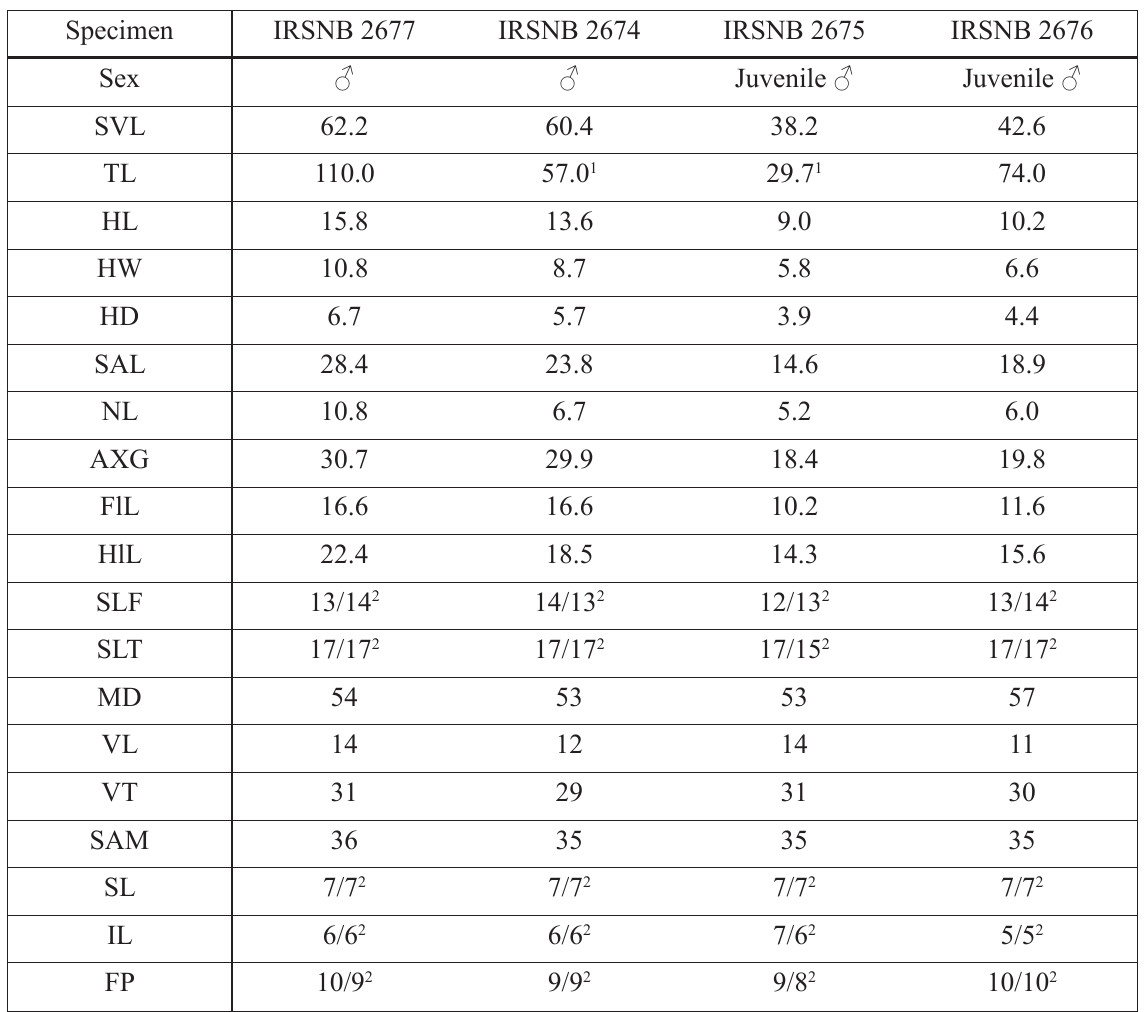
Table 1. Sex, measurements (in mm) and scale counts of the type series of Anadia mcdiarmidi sp. nov. 1 = tail incomplete or obviously regenerated, 2 = data corresponding to right/left side, other abbreviations are defined in the